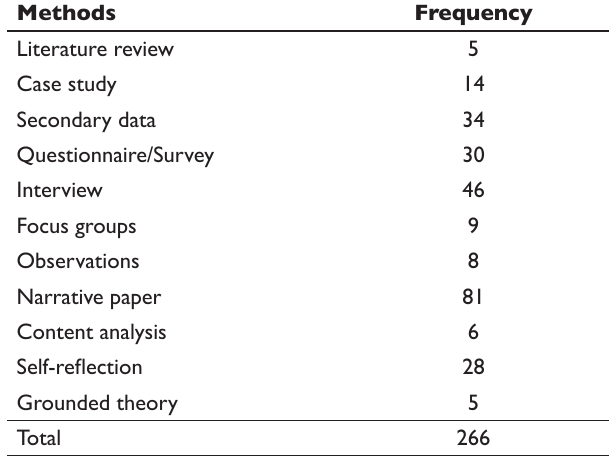
Table 4: Distribution of the literature by methods used Methods